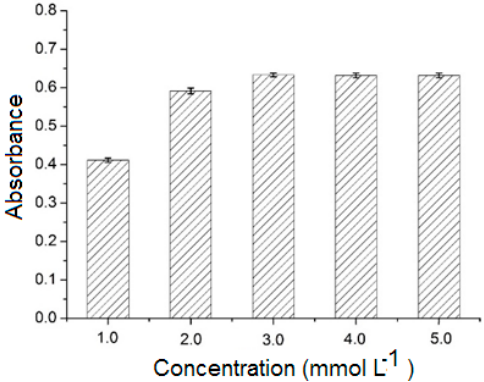
Figure 6. Effect of analyte concentration. Sample volume: 2.0 mL; and elution solvent: methanol (10 mL).